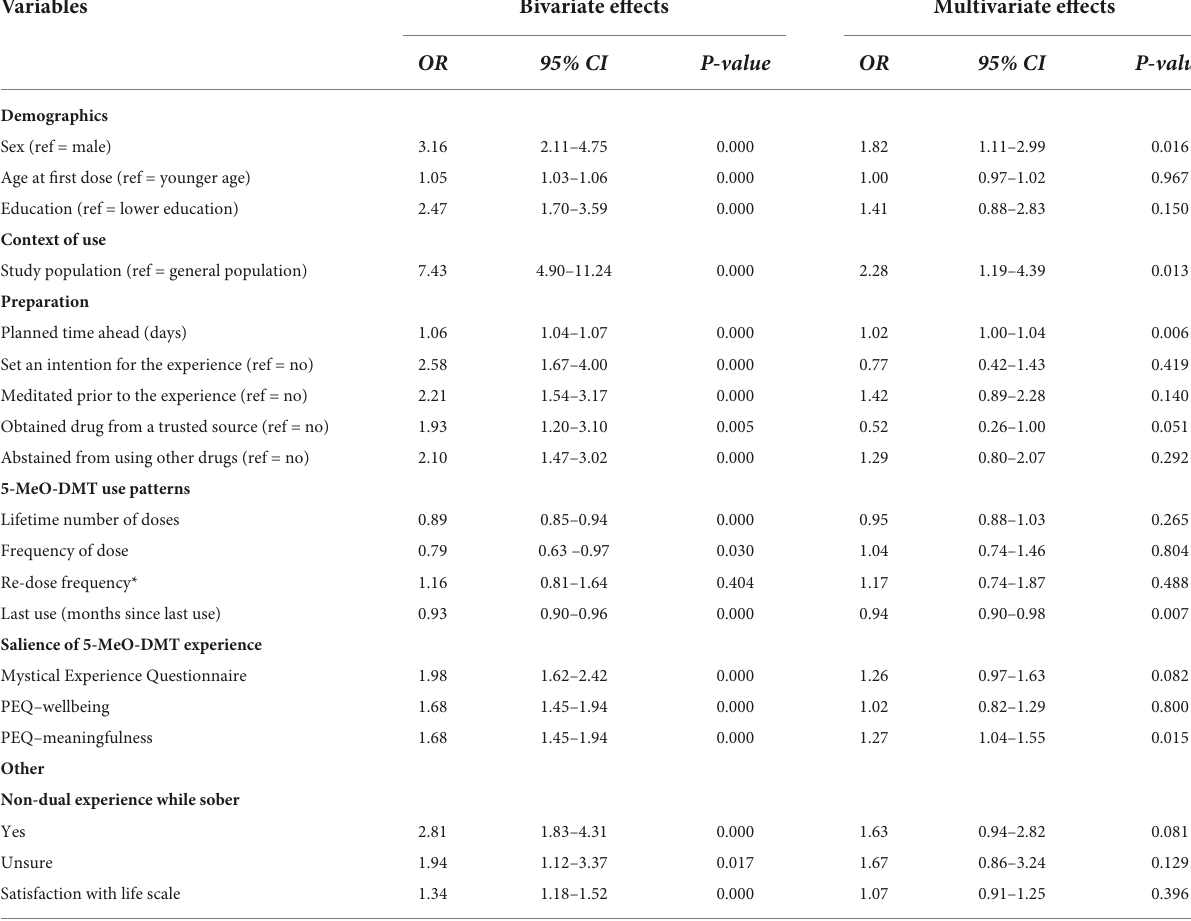
TABLE 3 Relationships between independent variables and occurrence of reactivation following use of synthetic 5-methoxy-N,N-dimethyltryptamine (5-MeO-DMT) in naturalistic settings ( n =